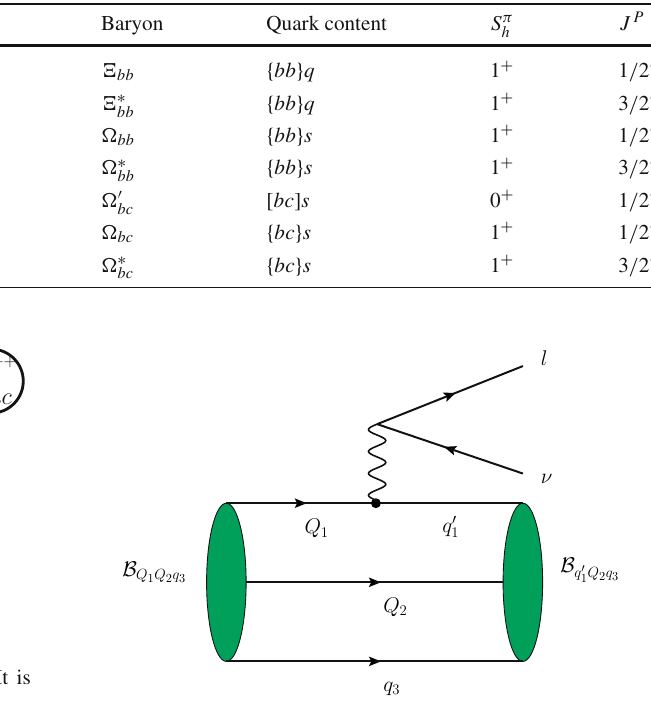
Fig. 2 Feynman diagram for semileptonic decays. The leptonic ampli- tude can be calculated using perturbation theory, while hadronic